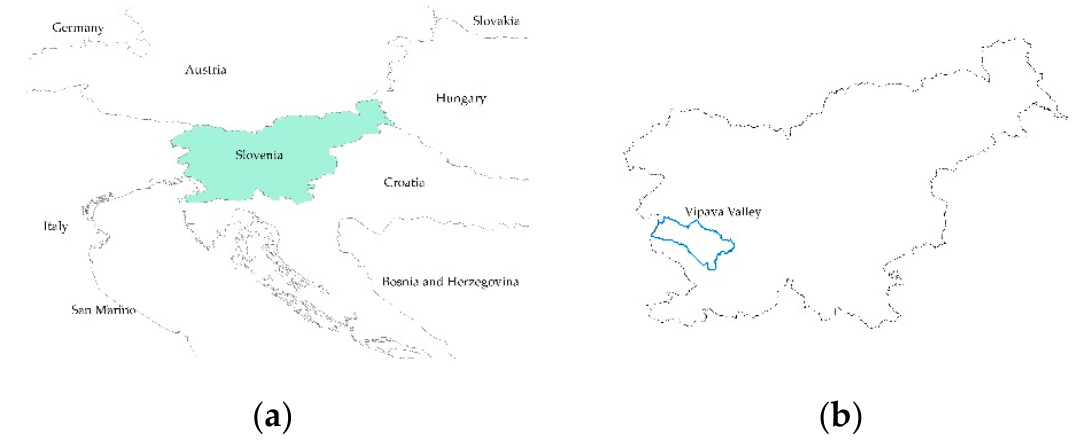
Figure 2. Case study area. ( a ) Country location; ( b ) Vipava Valley location.